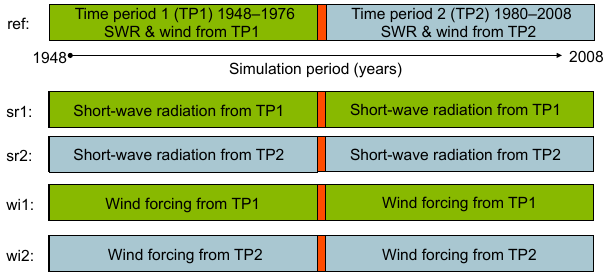
Figure 3. Schematic diagram for the scenario simulation set-up. The set-up is valid for the short-wave radiation experiments (sr1 and sr2) and for the wind experiments (wi1 and wi2); ref denotes the reference simulation as described in Daewel and Schrum